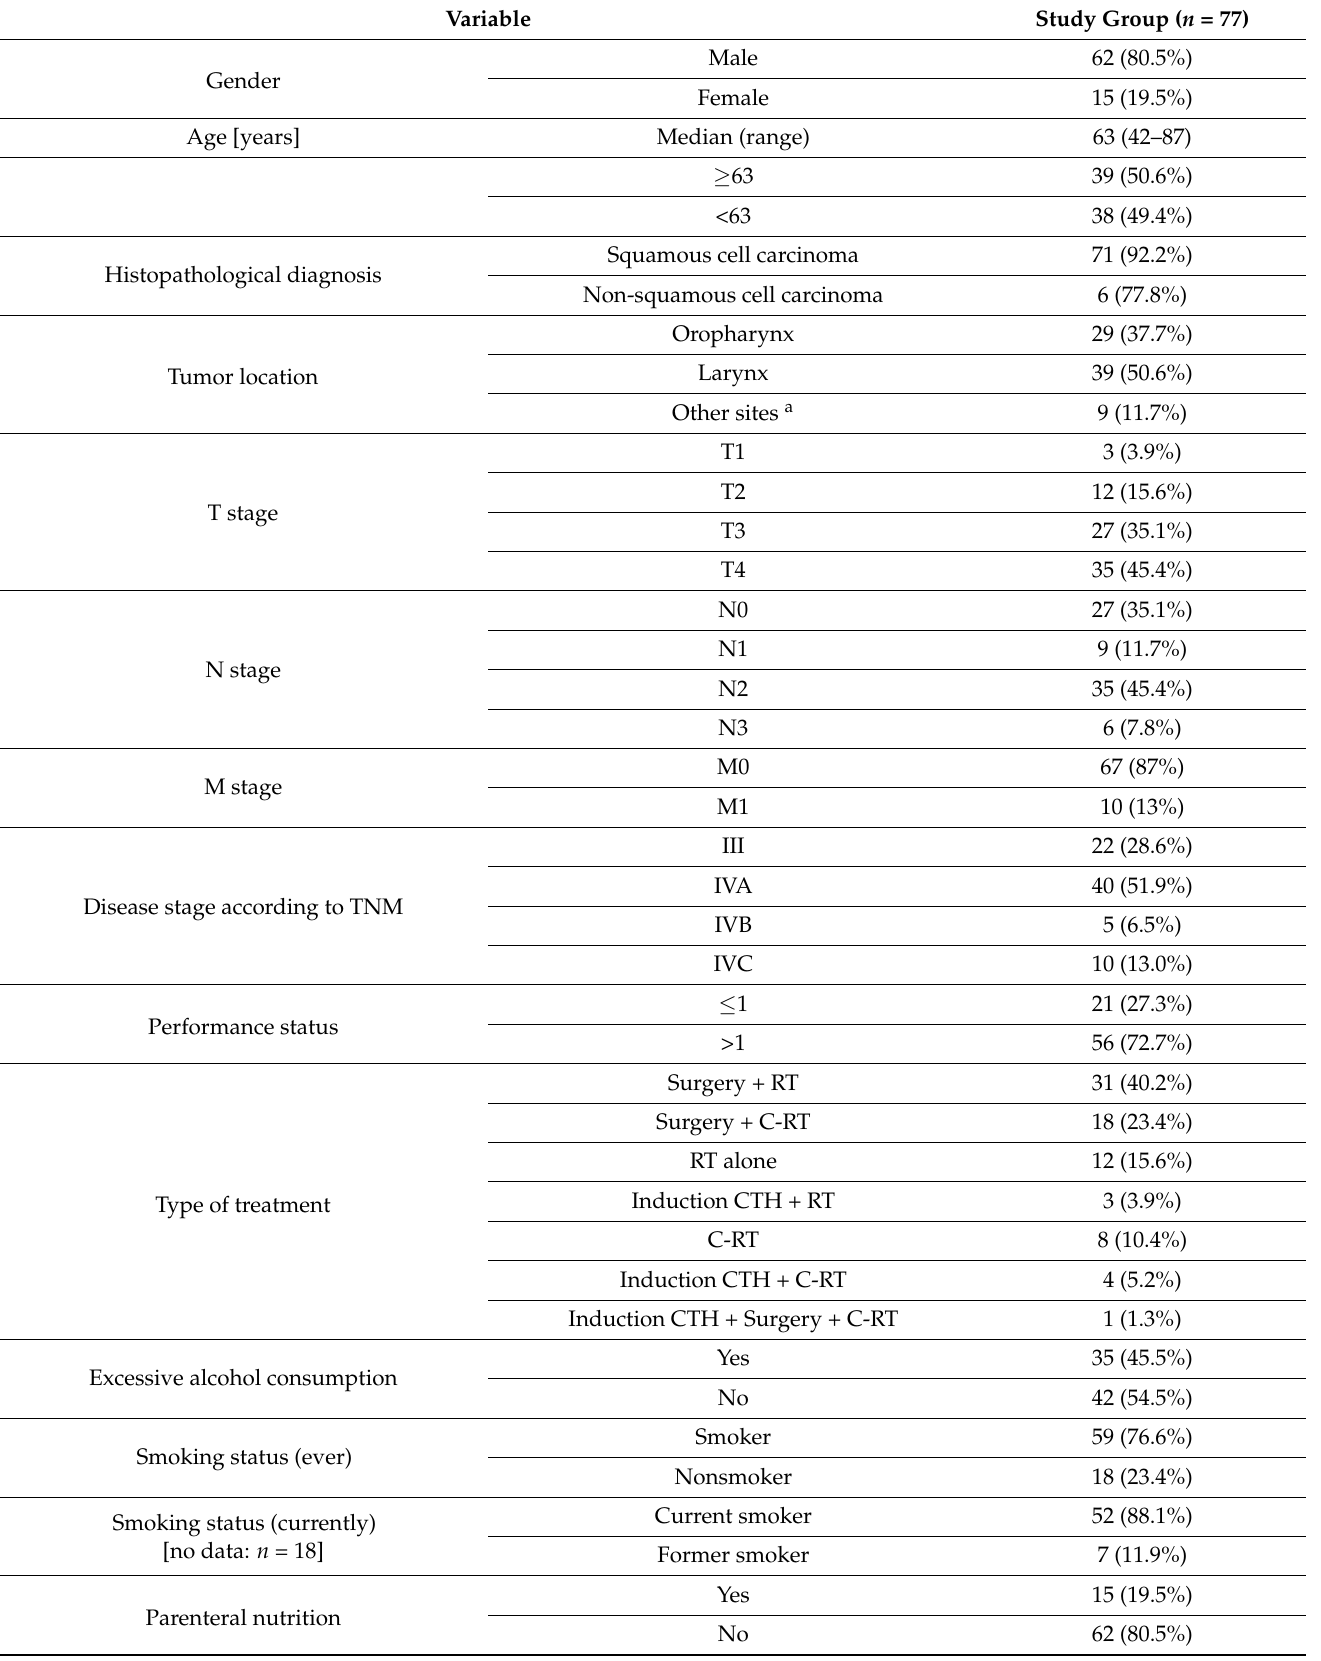
Table 1. Characteristics of the study